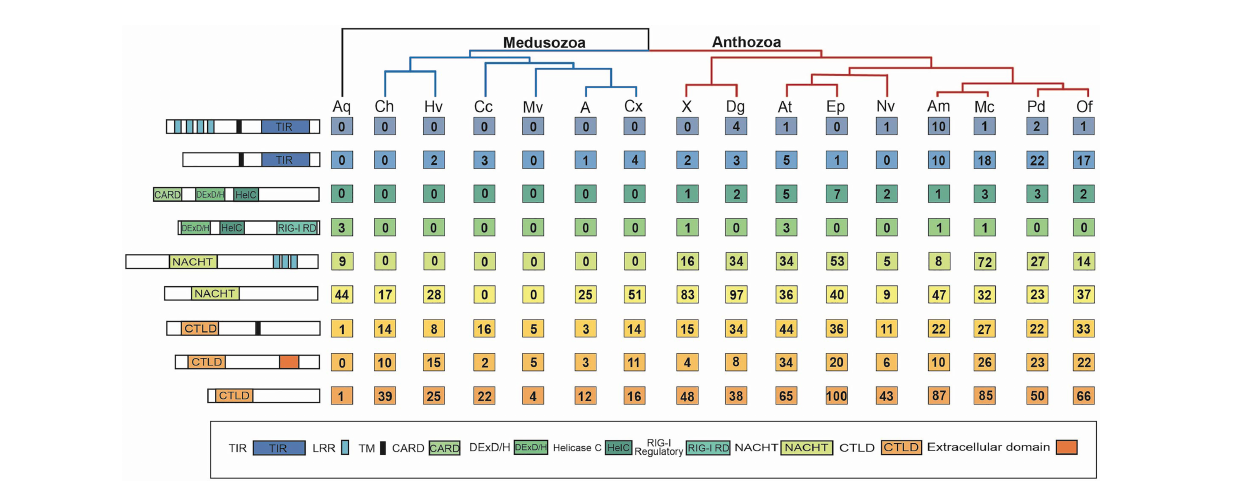
FIGURE 2 | Number of PRRs of each type found in each species. Far left shows schematics of the minimum domain composition for each PRR type, from top to bottom: prototypical TLR, TLR-like, RIG-I/MDA5-like, LGP2-like, prototypical NLR, NLR-like, transmembrane CTL, extracellular CTL, CTL with unknown localization. To the right of the schematics is the corresponding number of each PRR type found in each species ’ proteome. Species are grouped by phylogeny, with anthozoans in red, medusozoans in blue, and the sponge outgroup in black. Aq, Amphimedon queenslandica; Ch, Clytia hemisphaerica; Hv, Hydra vulgaris; Cc, Calavadosia cruxmelitensis; Mv, Morbakka virulenta; A, Aurelia sp.; Cx, Cassiopea xamachana; X, Xenia sp.; Dg, Dendonephthya gigantea; At, Actinia tenebrosa; Ep, Exaiptasia daiphana; Nv, Nematostella vectensis; Am, Acropora millepora; Mc, Montipora capitata; Pd, Pocillopora